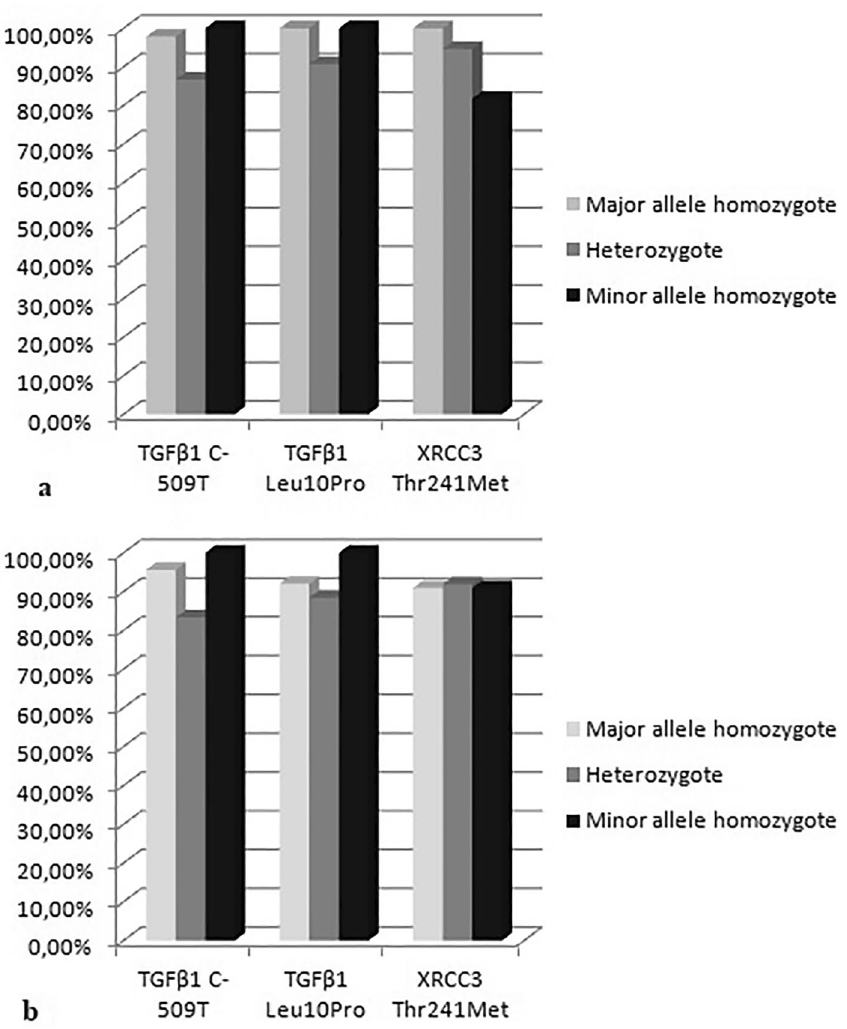
Figure 1. The differences in the distribution of genotypes of TGFB1 C-509T, TGFB1 Leu10Pro, and XRCC3 Thr241Met between patients with ( a) acute RT-induced GU toxicity and ( b) acute RT-induced GI